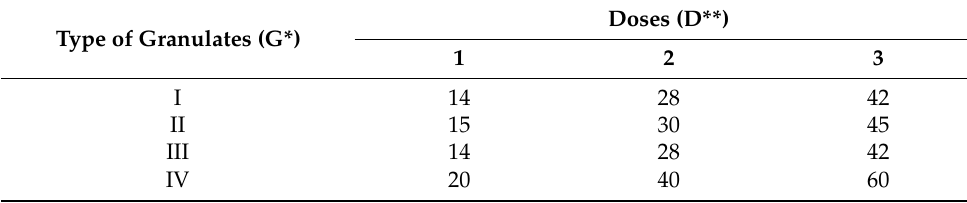
Table 3. Doses of applied granulates introduced in g/pot. Type of Granulates (G*)